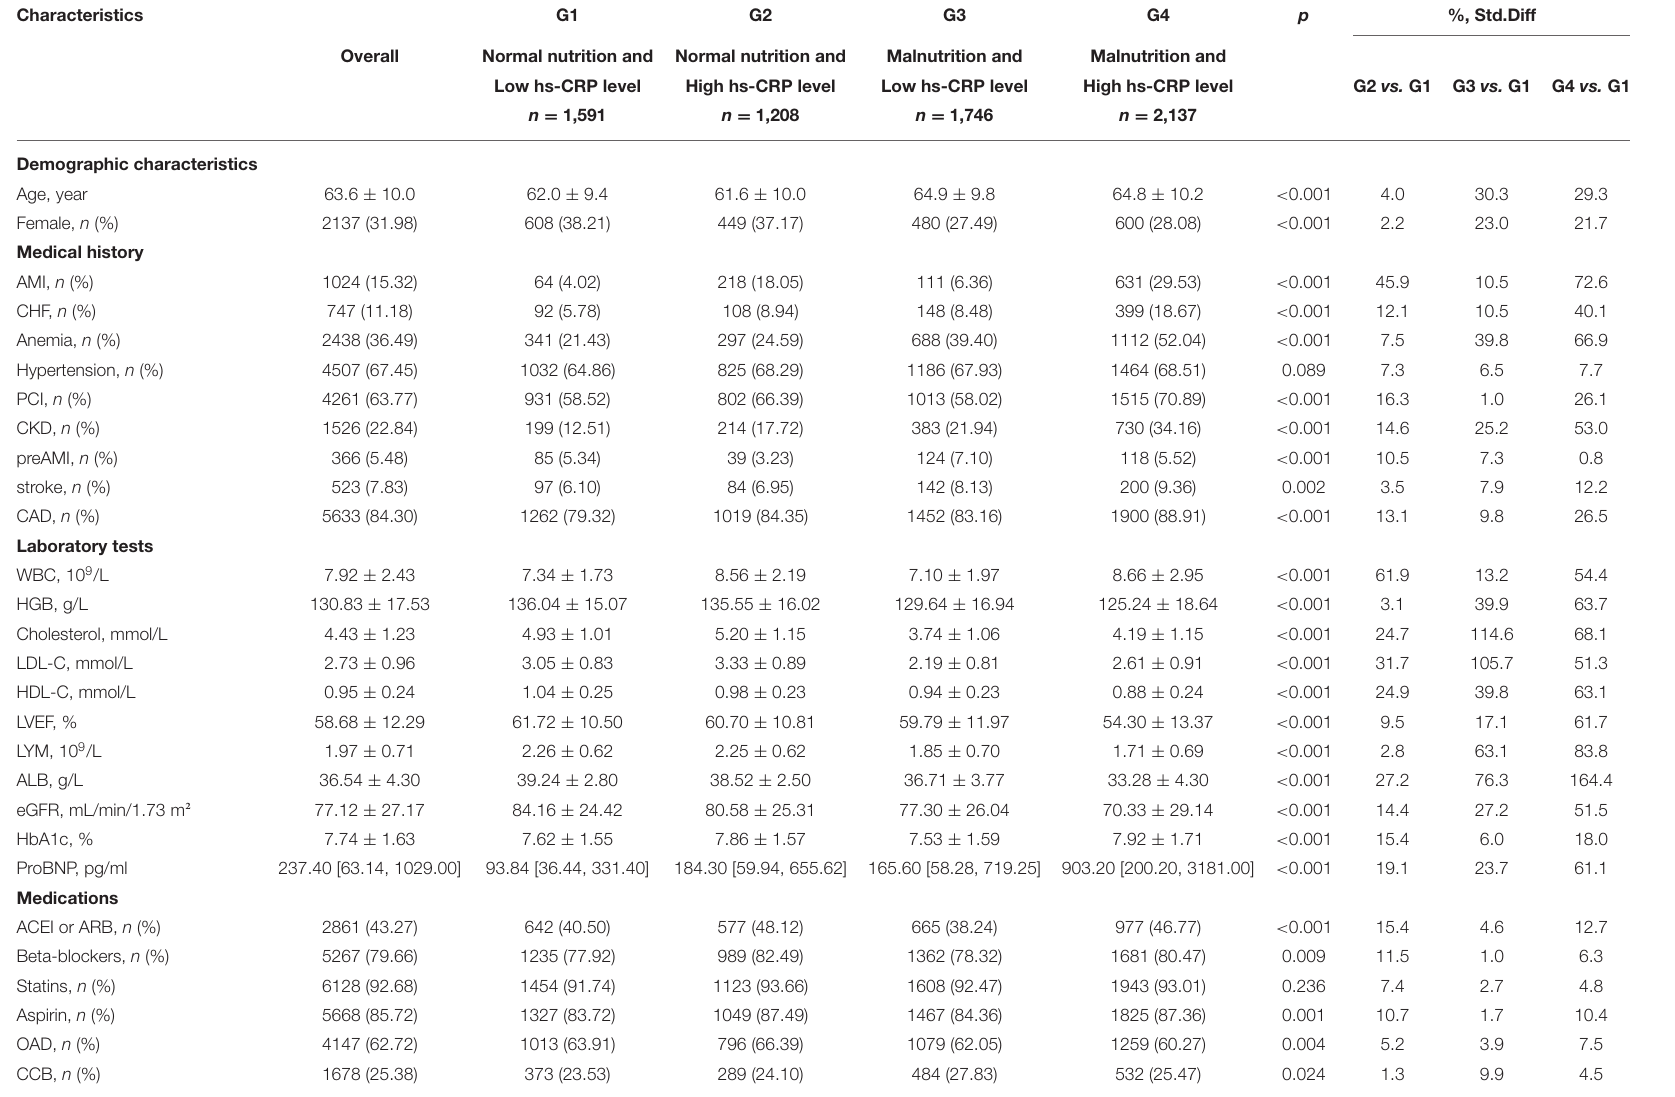
TABLE 1 | Baseline characteristics across CONUT score and high-sensitivity C-reactive protein categories.